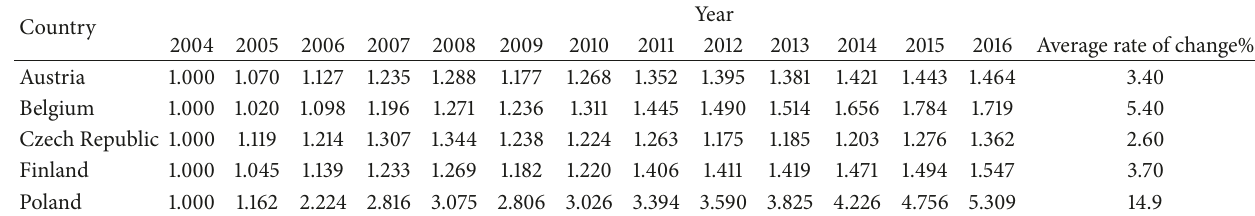
Table 3: Rate of change in the analyzed countries in 2004–2016.